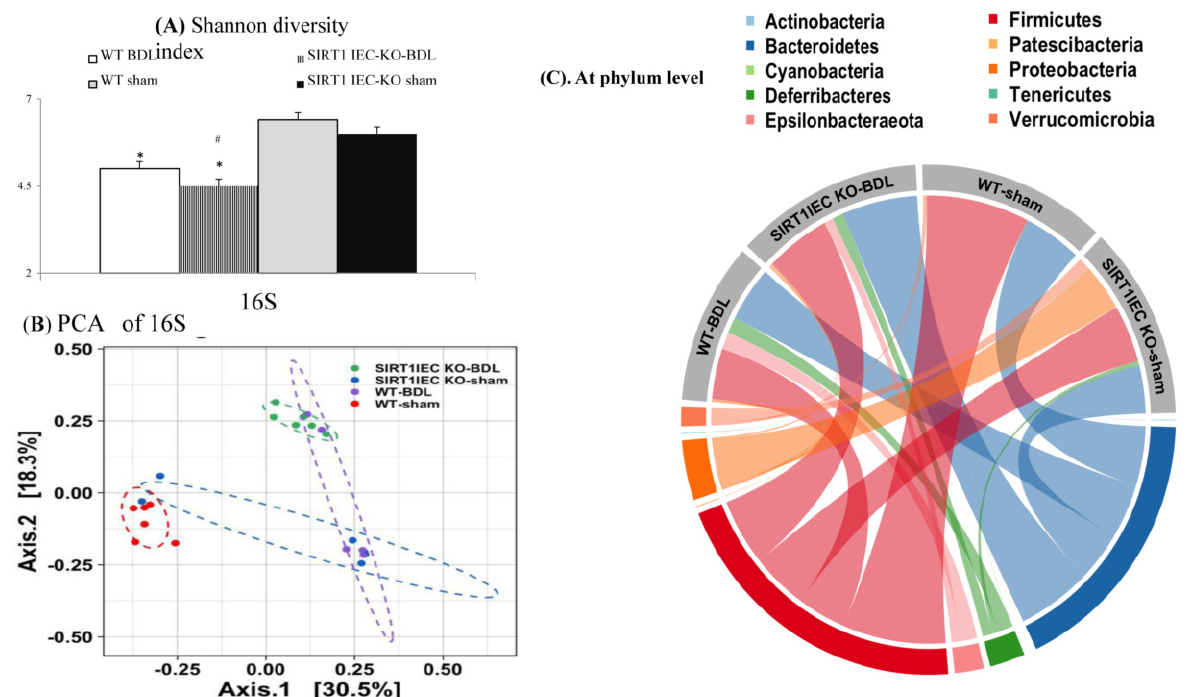
Figure 5. Genetic deletion of intestinal SIRT1 decreases the diversity of bacterial microbiota. ( A ) Simpson’s index for bacteria microbiota, ( B ) PCA plot among group, ( C ) chord diagram shows the parallel comparison of the overall abundance of intestinal microbiota of four groups. * vs. WT-sham mice; # vs. WT-BDL mice.